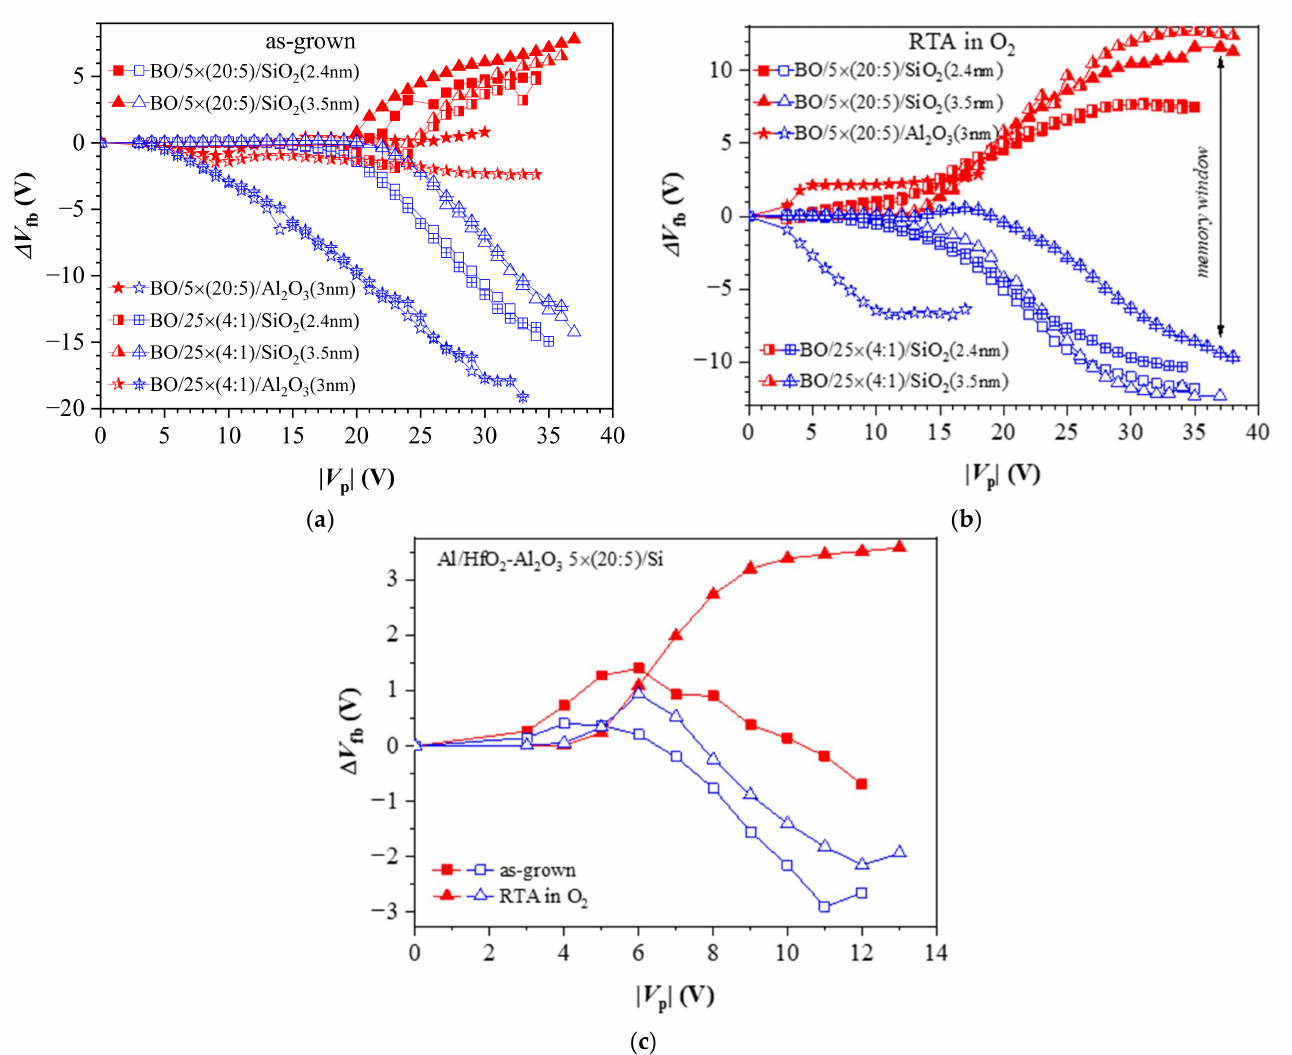
Figure 4. The flat band voltage shifts as a function of voltage pulse amplitude: ( a ) as-grown stacks; ( b ) after O 2 annealing; ( c ) 5 × (20:5) HfO 2 /Al 2 O 3 stack without any TO and BO . Red closed symbols correspond to + V p and the blue open symbols to – V p